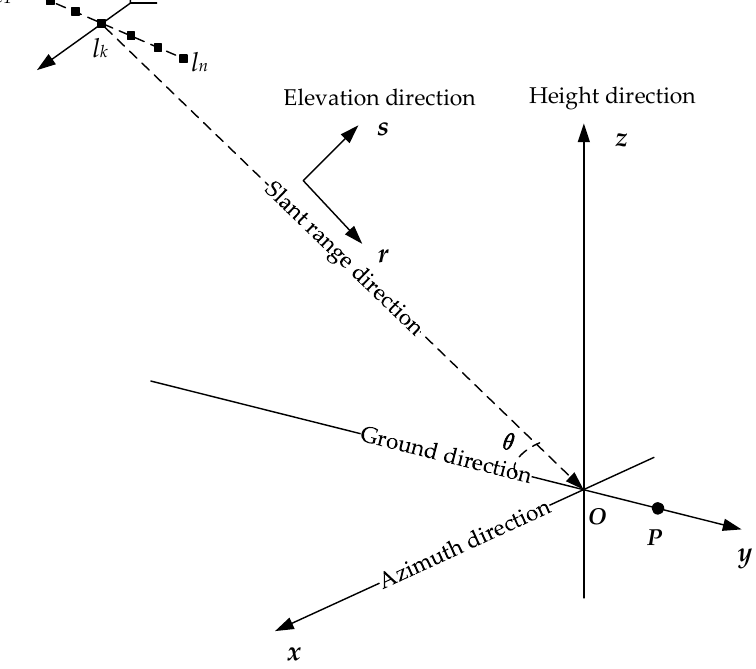
Figure 2. Schematic geometry of tomographic SAR (TomoSAR).